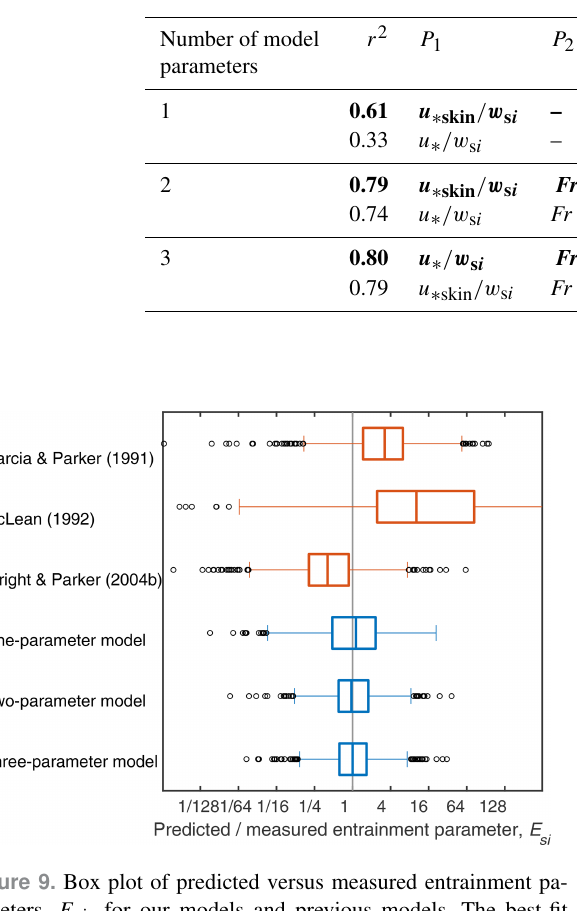
Figure 8. Best-fit models for the dimensionless entrainment rate, E s i , for grain-size-specific data with one parameter (a) , two parameters (b) , and three parameters (c) ; equations are in bold in Table 5. The plotting is done such that the exponent on the last parameter is unity to allow for comparison to plots of Garcia and Parker (1991) and Wright and Parker (2004b). Yellow filled symbols are the geometric mean, and the error bars indicate the geometric standard deviation within each bin. Table 5. One-, two-, and three-parameter models for the entrainment parameter of the form E s i = AP e 1 of each model are shown, one with u ∗ and one with u ∗ skin , and the bold value is the best fitting of the two (highest r 2 ). See Table S2 for all model fits.